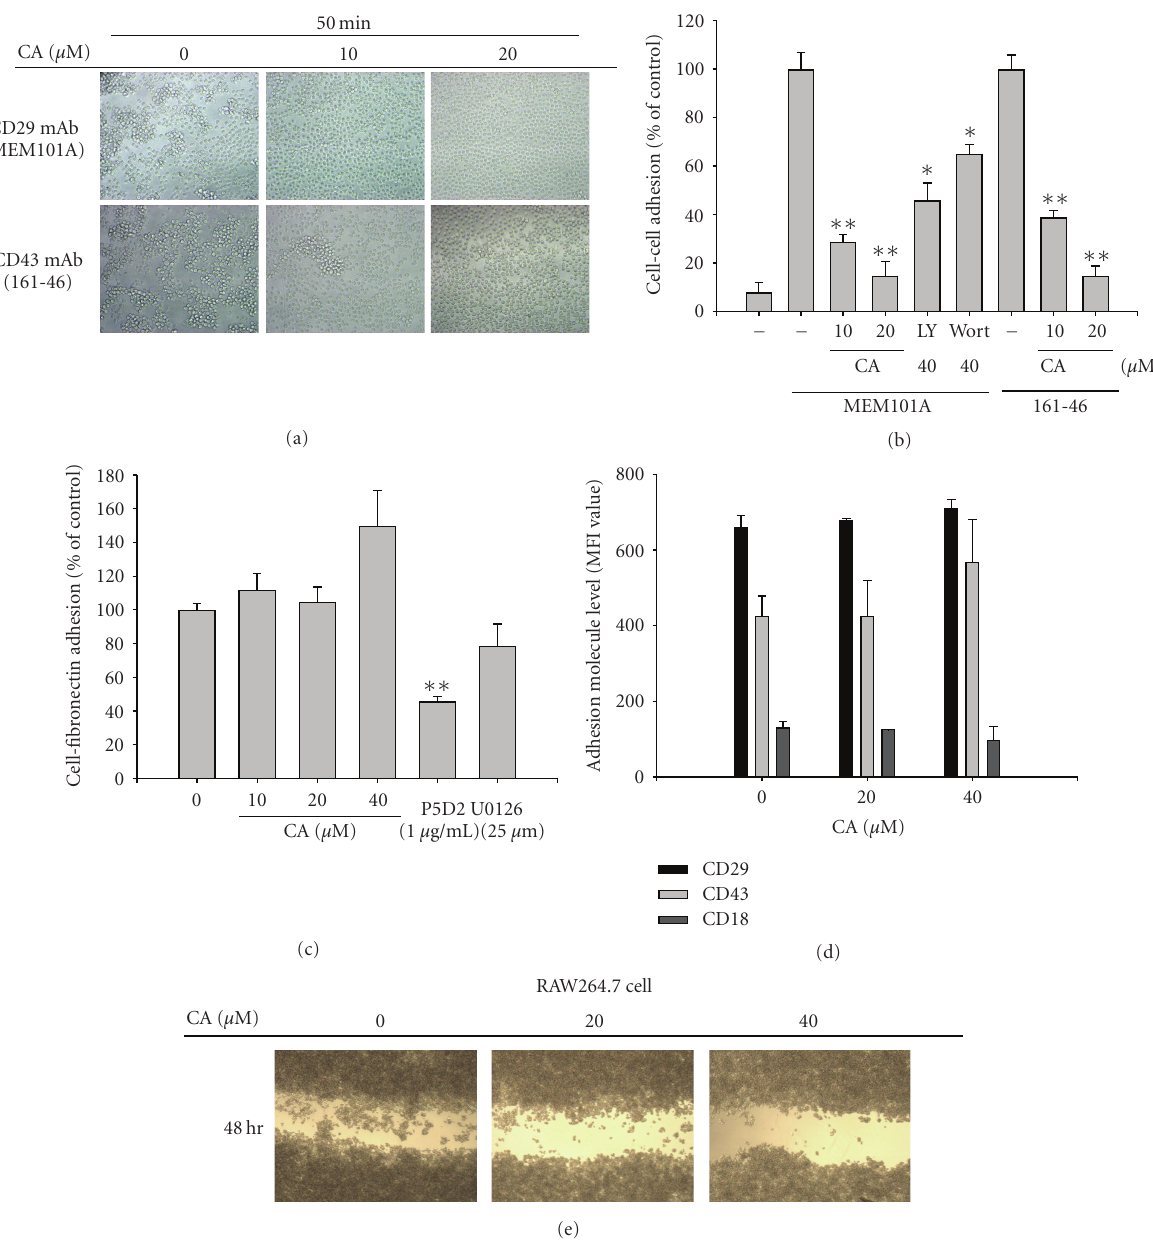
Figure 6: E ff ect of CA on cell-cell adhesion and cell-fibronectin adhesion. U937 cells pretreated with CA for 1h were incubated in the presence or absence of anti-CD29 antibody MEM101A (1 μ g/ml) or anti-CD43 antibody 161-46 (1 μ g/ml). Images (a) of the cells in culture were obtained using an inverted phase contrast microscope attached to a video camera. Quantitative analysis (b) of cell-cell clusters was assessed using a quantitative cell-cell adhesion assay. (c) U937 cells pretreated with CA, P5D2, or U0126 for 30min were seeded on fibronectin-coated (50 μ g/ml) plates and further incubated for 3h. The number of attached cells was determined by crystal violet assay. (d) U937 cells (1 × 10 6 cells/ml) were incubated with CA for 12h. Surface levels of CD29, CD18, and CD43 were determined by flow cytometric analysis. (e) RAW264.7 cells (2 × 10 6 cells/ml) pretreated with CA for 1h were incubated for 48h after scratching with a pipette. Images of the cells in culture were obtained using an inverted phase contrast microscope attached to a video camera. ∗ P < . 05 and ∗∗ P < . 01 represent significant di ff erence compared to